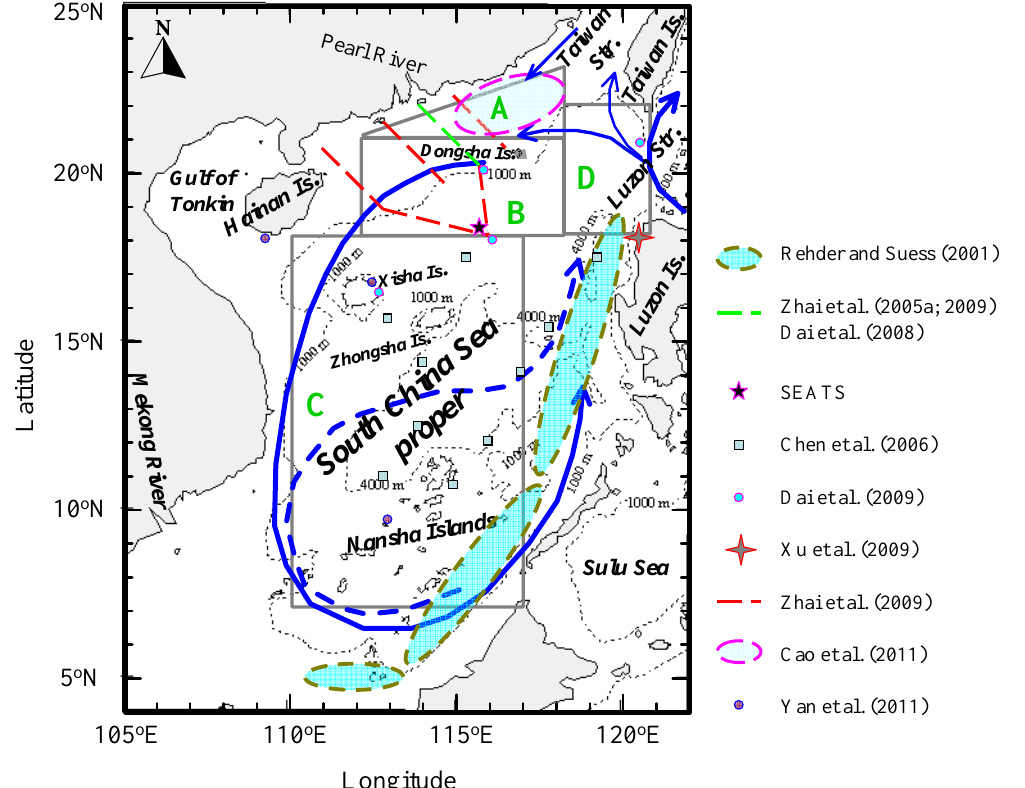
Fig. 1. Map of the South China Sea (SCS) proper under study. Framed areas indicate the four physical–biogeochemical domains this study categorized, as detailed in Table 1. Blue curves represent the basin-wide cyclonic gyre in winter (solid curve in the SCS) and the anticyclonic gyre over the southern half of the sea during the summer (dashed curve in the SCS) and the Kuroshio and its intrusions (solid curves around the Luzon Strait) into the northern SCS. All published studies related to sea–air CO 2 fluxes in the SCS proper are summarized (see the text for details). Note that the sea–air CO 2 fluxes at the SEATS station have been well studied in Chou et al. (2005), Tseng et al. (2007), and Sheu et al.